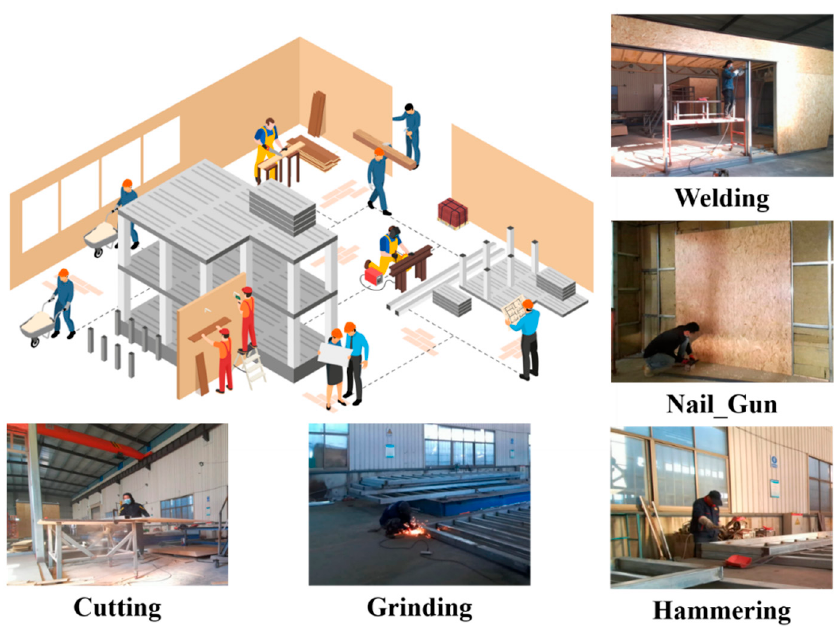
Figure 8. Five types of construction sound in the steel modular construction factory.